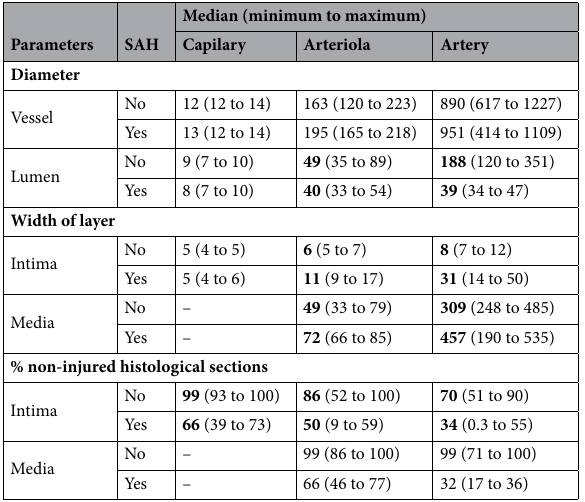
Table 2. Morphometric data obtained from the microvasculature of the posterior nasal cavity of individuals with or without systemic arterial hypertension. Bold pairs = Different values ( p <